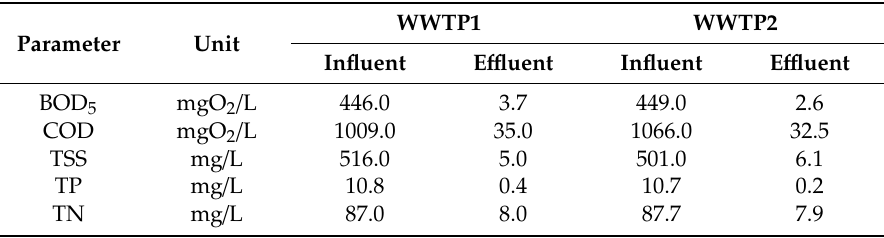
Table 4. Main technological parameters of the studied